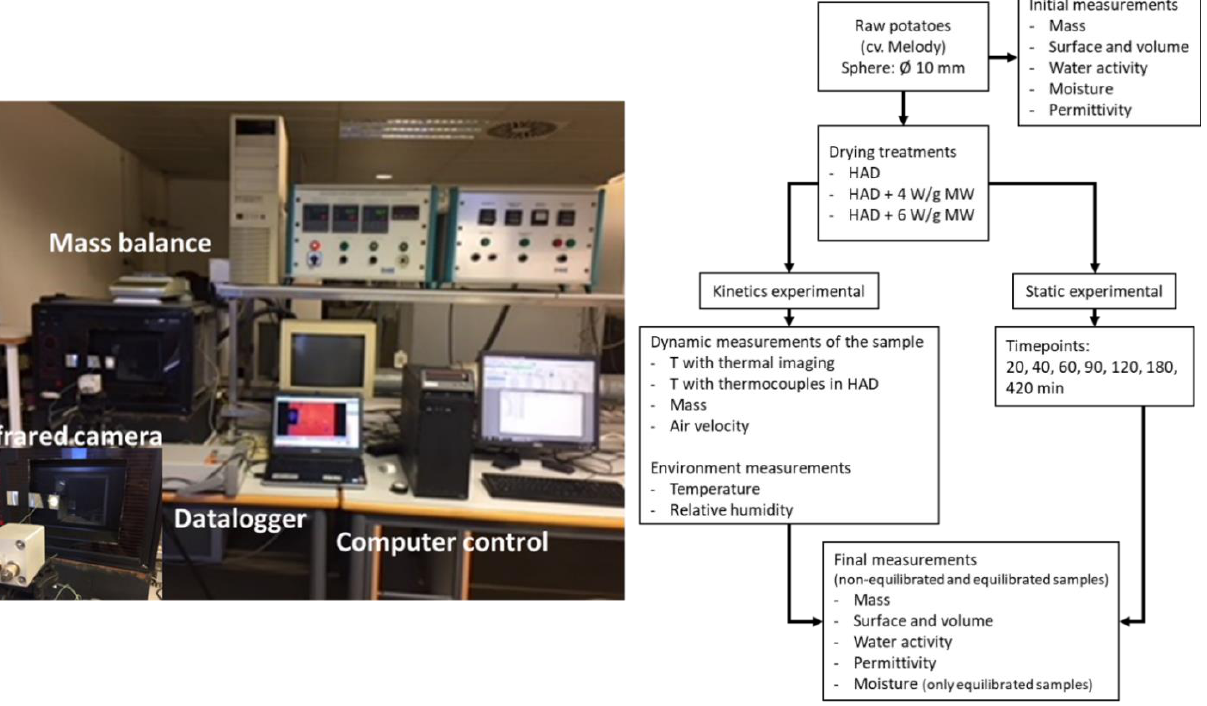
Figure 1. Experimental setup and diagram of the experimental procedure.